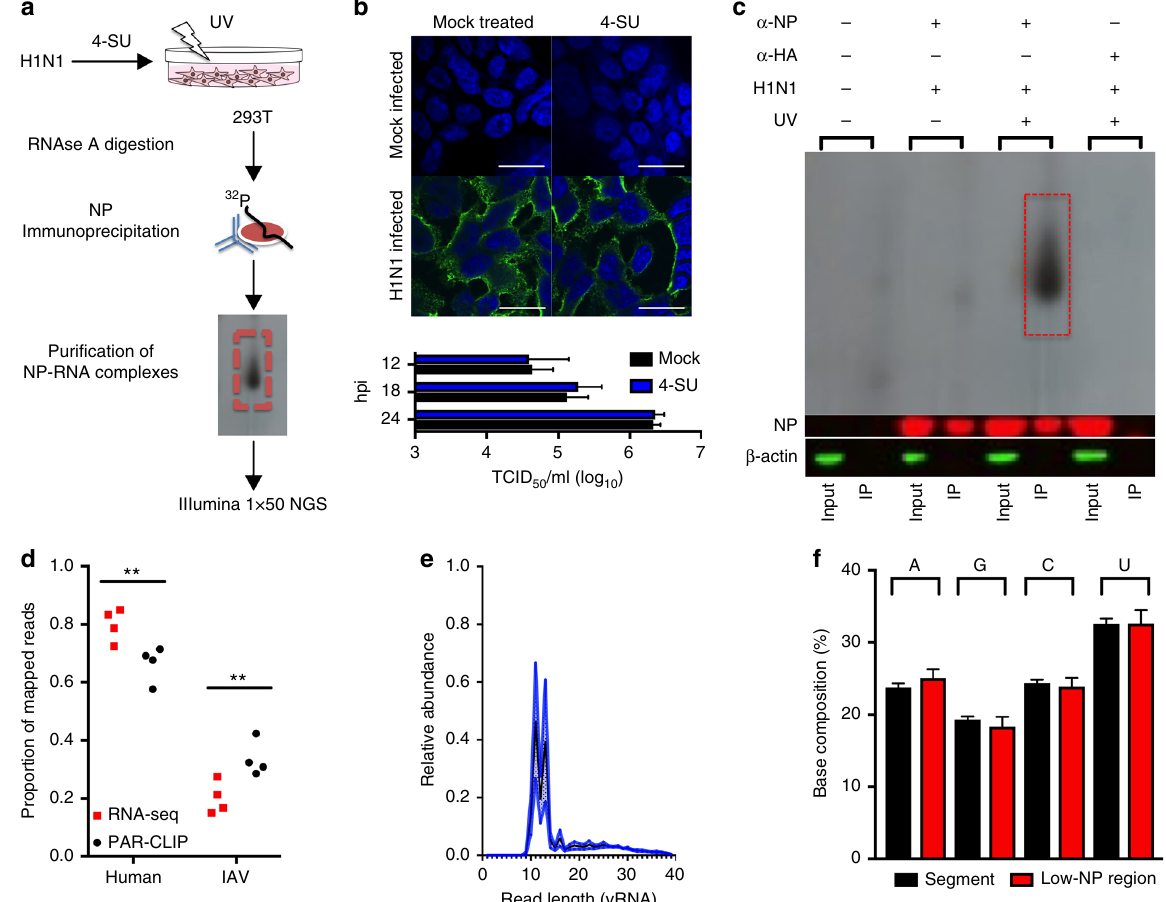
Fig. 1 Development of PAR-CLIP for IAV NP. a Schematic for IAV NP PAR-CLIP assay. b Effects of 4-SU on IAV replication. Viral replication (MOI = 0.1) in the presence or absence of 4-SU (100 μ M) was assessed by performing a growth curve at the indicated times in 293T cells and titered by TCID 50 assay in MDCK cells (bottom). Results are the average + s.e.m. of two experiments. NP localization was assessed following treatment and infection of 293T cells by confocal microscopy (top). Immuno fl uorescence staining for NP (green) was assessed in the presence or absence of 4-SU and counterstained with DAPI to identify cellular nuclei (blue). Scale bar indicates 25 µ m. c PAR-CLIP was conducted on 293T cells infected with WT-PR8 in the absence (lanes 1 and 2) or presence of a monoclonal antibody against to IAV NP (lanes 3 – 6) or viral hemagglutinin protein (HA) (lanes 7 – 8). The effect of UV cross-linking on binding of RNA to the viral NP is shown in lanes 3 – 4 (no UV) and lanes 5 – 6 (with UV). Radioactivity ( 32 P) is visualized by autoradiograph and the presence or absence of NP and cellular ß-actin was done by western blot. The input sample and eluate are loaded in the uneven and even lanes, respectively. The results are representative of four independent experiments. Original western blots and autoradiograph are shown in Supplementary Fig. 7. d Proportion of PAR-CLIP or RNA-seq derived reads mapping to human or IAV genomes (** P < 0.01 by one-way ANOVA with multiple comparisons correction (Kruskal – Wallis test), n = 4). e Length of negative-sense viral RNA (vRNA) aligning reads was determined using FastX Toolkit and the number of reads of a certain length is plotted as a proportion of total vRNA mapping reads. Mean (black line) ± s.e.m. (blue shading) of 4 experiments. f Nucleotide composition of low-NP-binding regions and IAV genome (displayed as average + s.e.m. base composition of all eight gene-segments). No signi fi cant differences were detected between groups (one-way ANOVA with multiple comparisons correction (Kruskal – Wallis